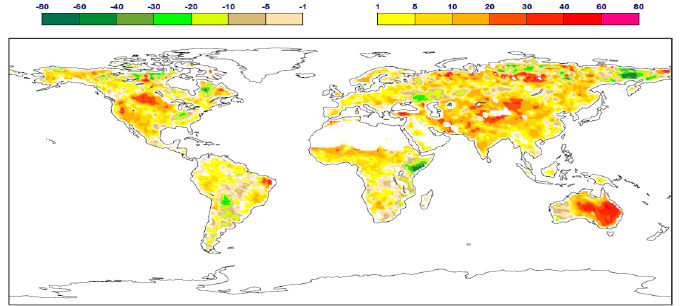
Figure 13. Above ground biomass-based Anomaly Index ( AI AGB ) for November 2010 in % of the 1999–2013